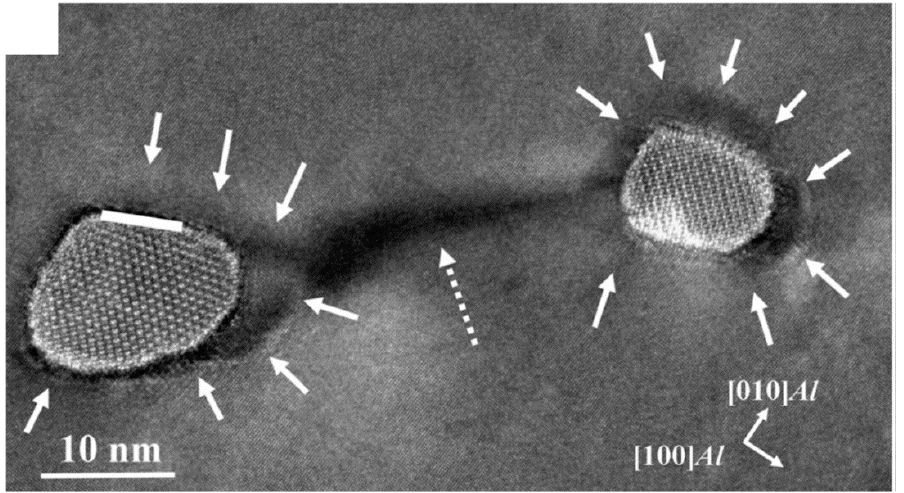
Figure 20. TEM image of looping interactions around particles. (Reprinted from Reference [21], with permission from Elsevier).